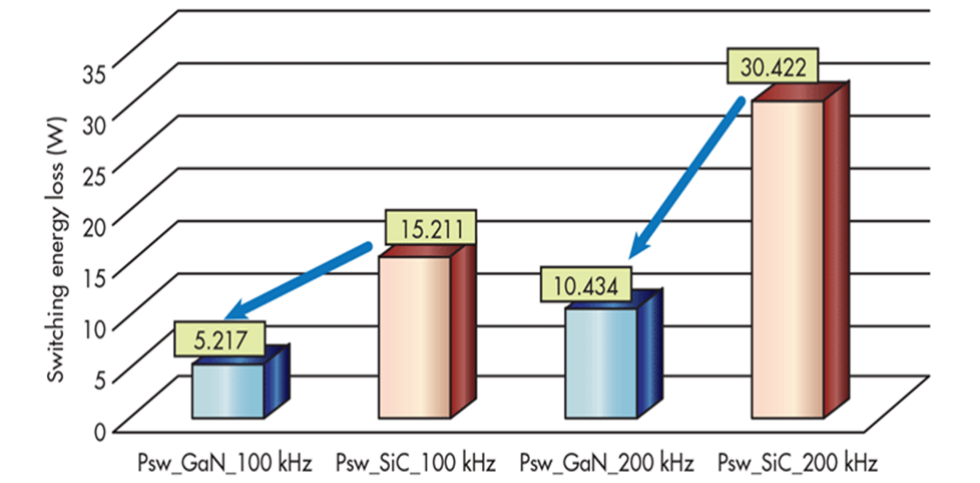
Figure 6. Switching loss comparison between GaN Systems’ GS66508T E-HEMT and Cree’s (Wolfspeed’s) C3M0065090J SiC MOSFET (after [4]).